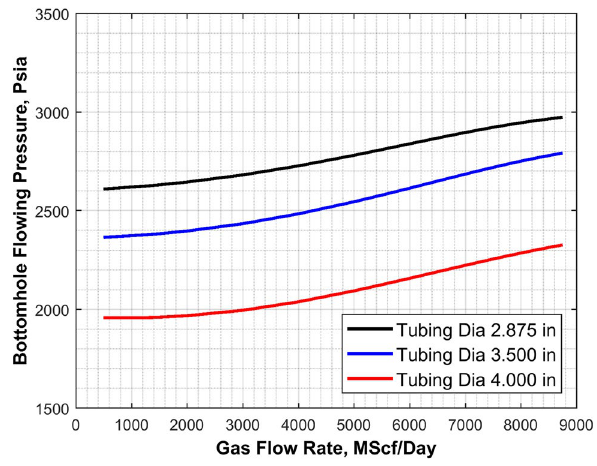
Fig. 9 Effect of changing gas rate on flowing bottom-hole pressure at tubing IDs of 2.875, 3.500 and 4.000 inches